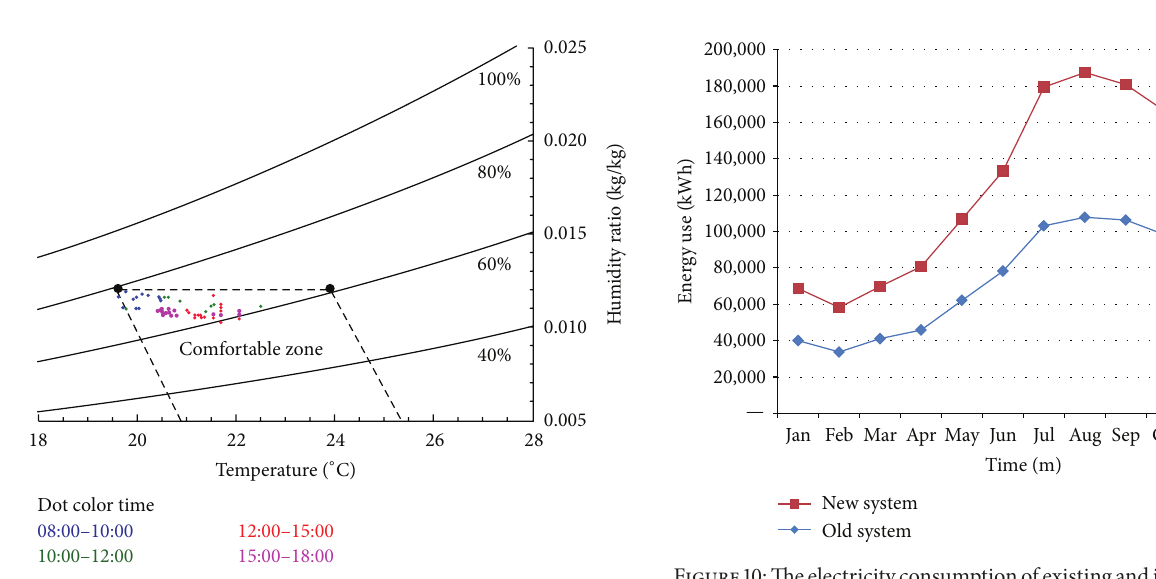
Figure 9: Dot distribution of the environment temperature, humid- ity, and thermal comfort in the summer after improvement.